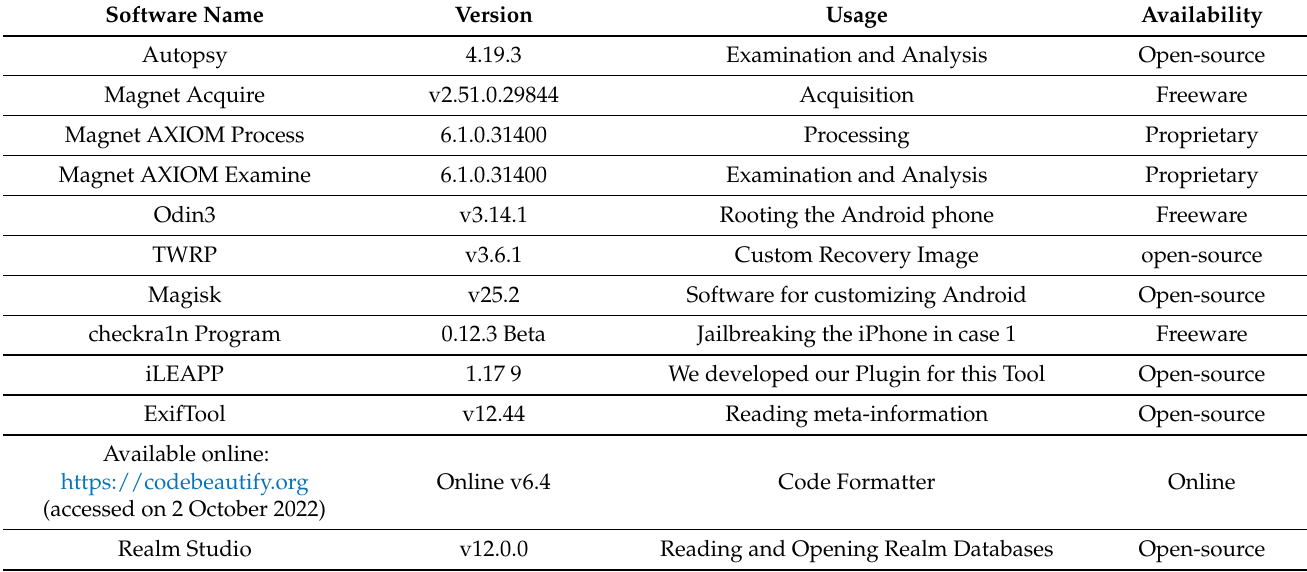
Table 4. Tools and applications